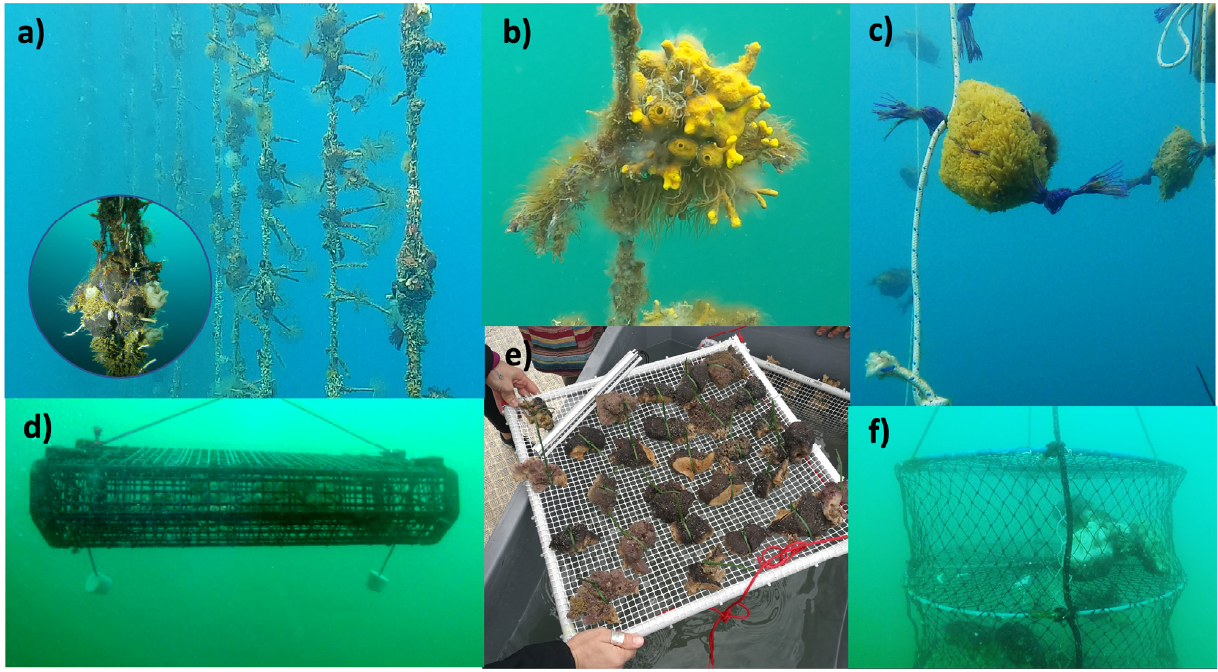
Figure 5. Main rearing methods in Remedia Life (upper) and ASMAR (lower) IMTA systems. Sarcotragus spinosulus reared in tubular nets ( a ), Aplysina aerophoba ( b ), and Hymeniacydon perlevis ( c ) reared in rope systems with net bags in the Maricoltura del Mar Grande fish farm (Mar Grande of Taranto, northern Ionian Sea); S. spinosulus in SEAPA nets ( d ), mesh panels ( e ) and lantern nets ( f ) close to Gargano fish farm (Gulf of Manfredonia, south-eastern Adriatic Sea). ASMAR project: Assessment of Sponge Mariculture Potential in Polyculture System in the Manfredonia Gulf–Interreg Adrion Blue Boost 2019–2020.